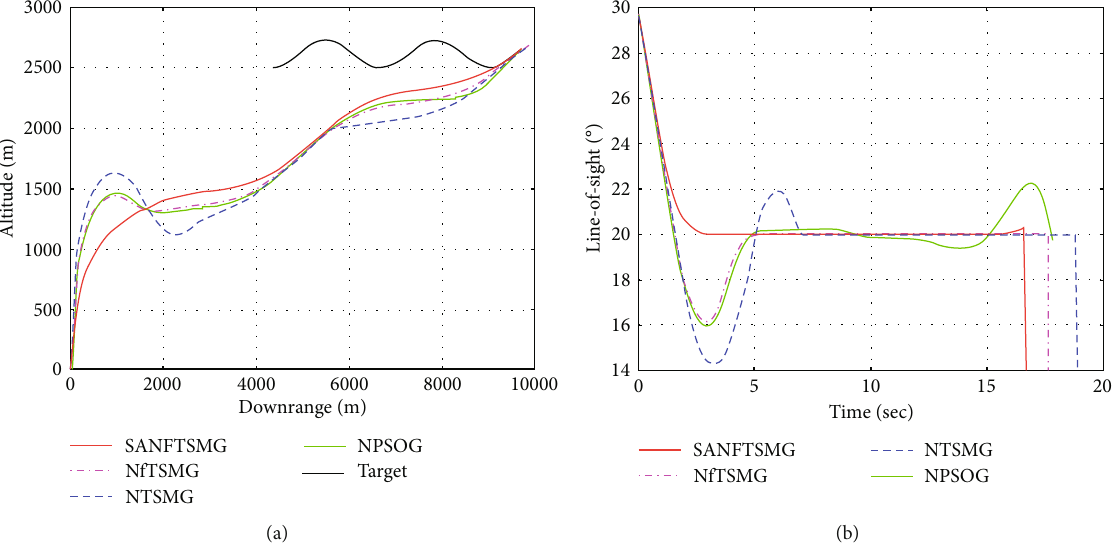
Figure 9: Simulation results of intercepting weave-maneuvering targets. Table 3: The miss distance and interception time with di ff erent guidance